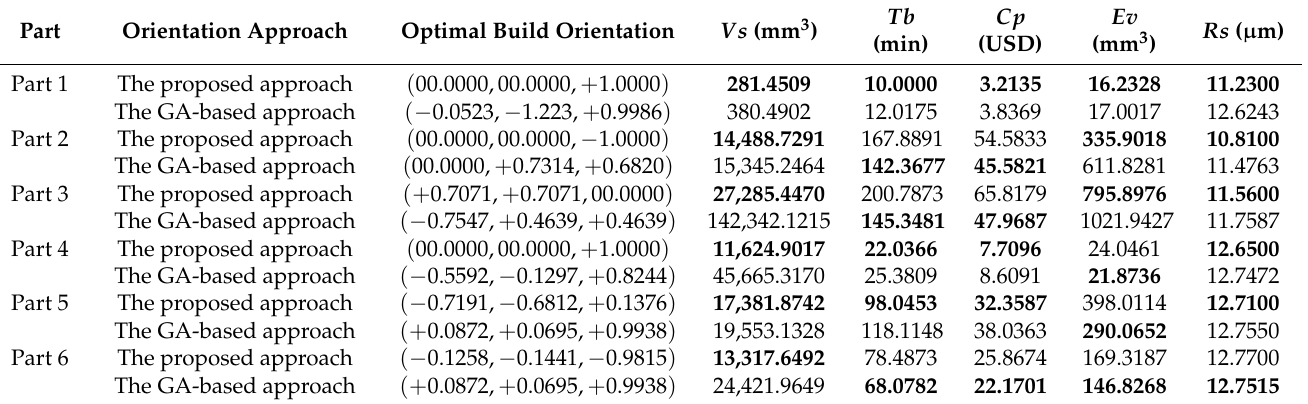
Table 2. Results of the effectiveness comparison based on theoretical